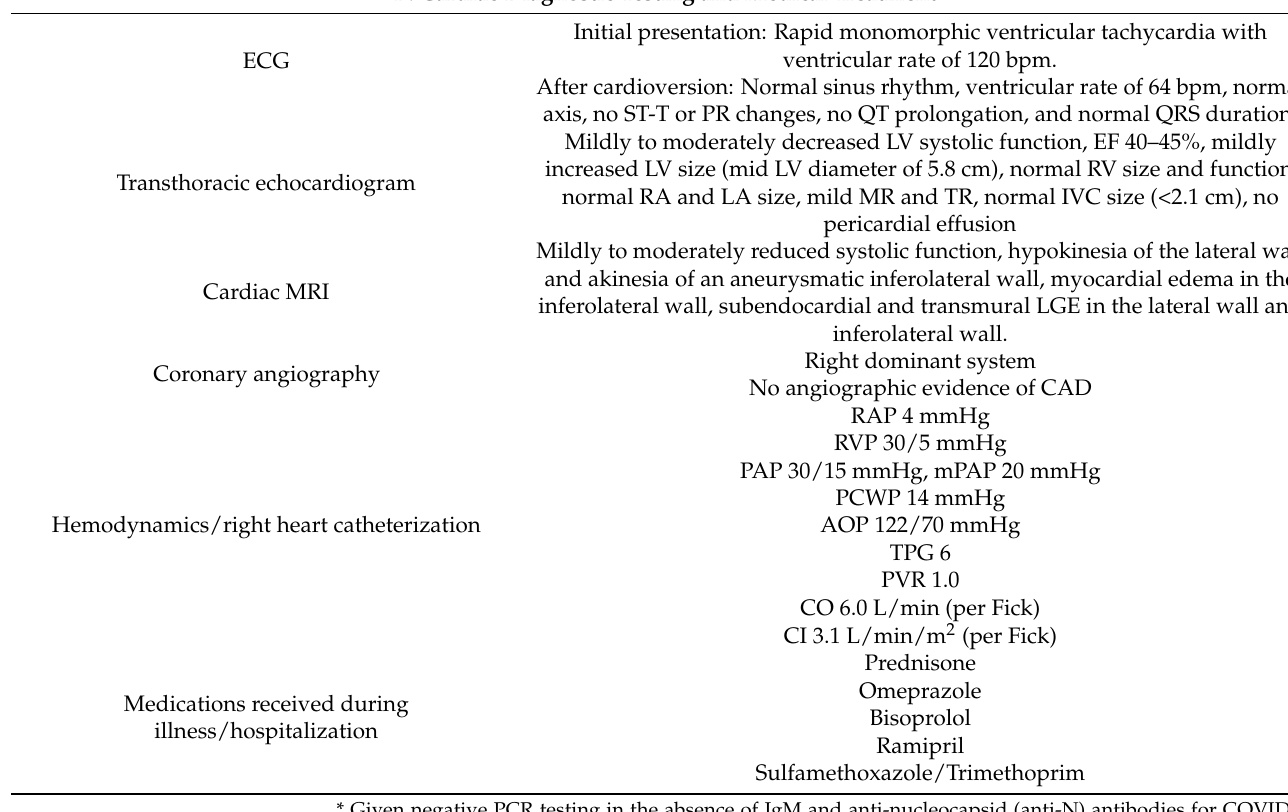
Table 1. Cont. B: Cardiac Diagnostic Testing and Medical Treatment